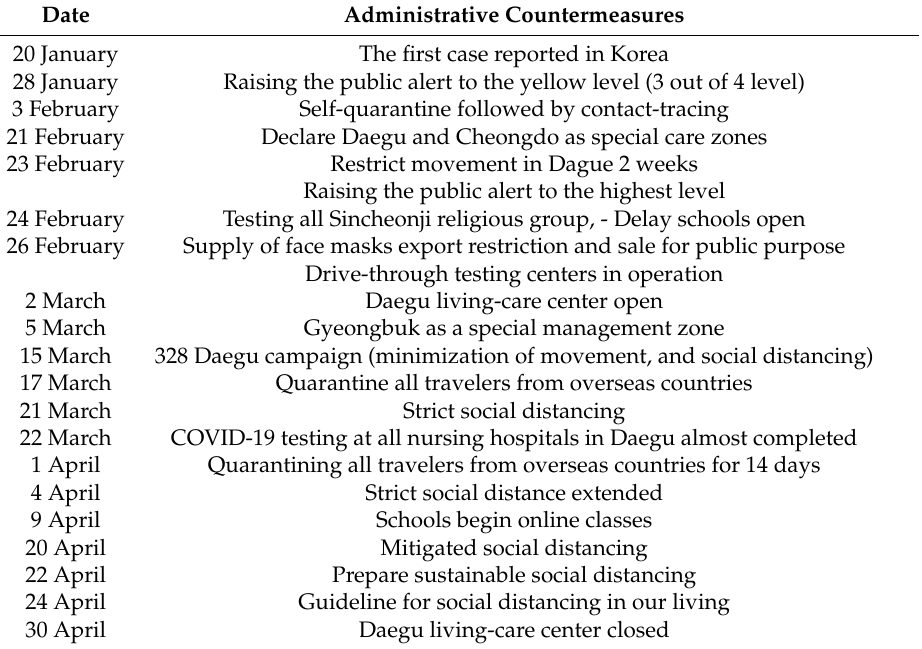
Figure 2. The time series of daily incidence in Daegu and Gyeongbuk (grey bar) is compared with the daily incidence in the rest of South Korea (green bar). Administrative countermeasures are implemented by the Korean government (Daegu and Gyeongbuk). Table 1. Administrative countermeasures implemented by the Korean government (Daegu and Gyeongbuk)